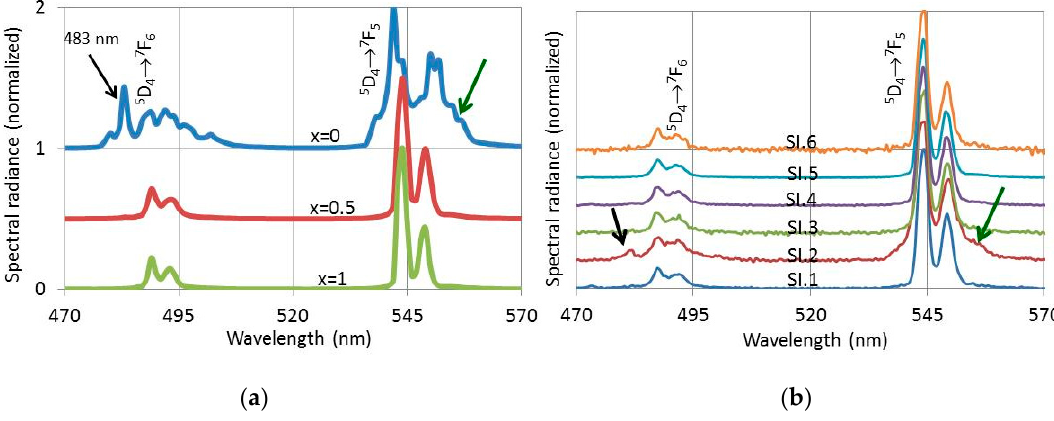
Figure 11. Spectra of (Lu 1 ‐ x Gd x ) 2 O 2 S:2%Tb 3+ between 470 nm and 570 nm: ( a ) PL spectra (excited at 291 nm) of phosphors with x Gd = 0, 0.5 and 1; and ( b ) CL spectra of the (Lu 0.5 Gd 0.5 ) 2 O 2 S:2%Tb 3+ crystals shown in Figure 9b excited at 200 keV and room temperature in the TEM.